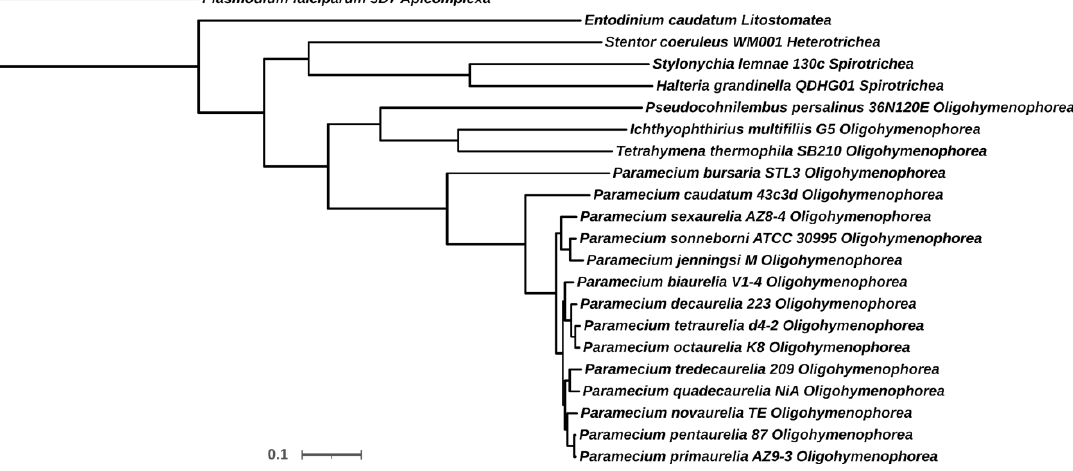
Figure 1. Phylogenetic tree of selected species of ciliates. Protein datasets were downloaded either from ParameciumDB or NCBI, except for Entodinium caudatum , which was kindly provided by Drs. Yu and Park from Ohio State University, OH, USA. All proteomes were used for feeding Orthofinder (see text above for reference). A total of 507 orthogroups with all the species was used to build the tree, using the STAG algorithm included in Orthofinder. The inferred tree was drawn with iTOOL [36]. P. falciparum , an apicomplexan close relative of ciliates, was selected as outgroup by the STRIDE algorithm, also included in Orthofinder. For each species, the full name, strain, and Class to which each species belongs are shown, except for P. falciparum , for which the Phylum was written instead of the Class. The scale bar represents the average number of substitutions per sites across of the 507 orthogroups used.